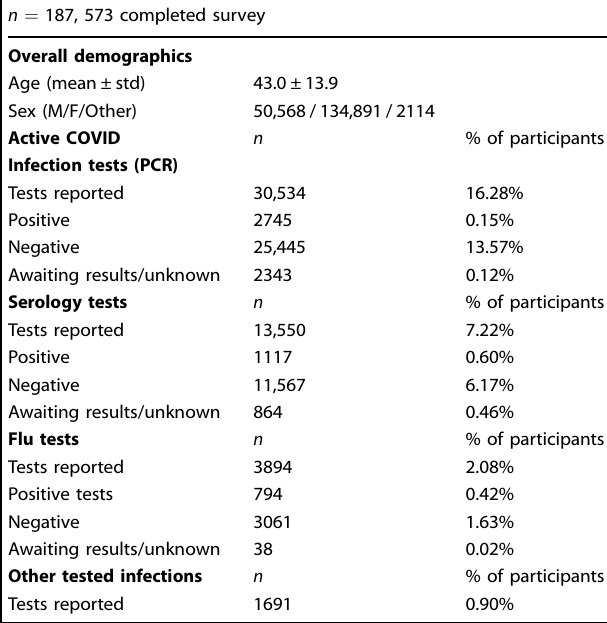
Table 2. Breakdown of overall survey results by summary demographics and test